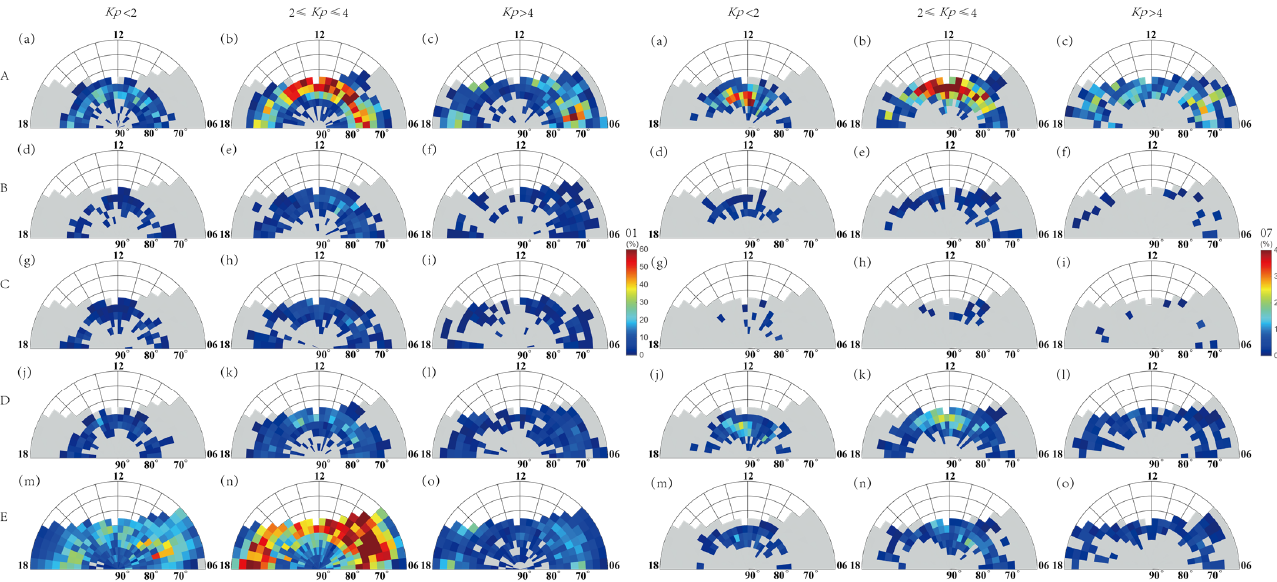
Figure 4. Temporal–spatial distribution of different types of ion upflows under different geomagnetic activities. From top to bottom are ion upflows of type A to E, respectively. The three columns on the left are statistics for January, and the right are statistics for July. ( a , d , g , j , m ) Quiet magnetic activities, ( b , e , h , k , n ) moderate magnetic activities, ( c , f , i , l , o ) disturbed magnetic activities.